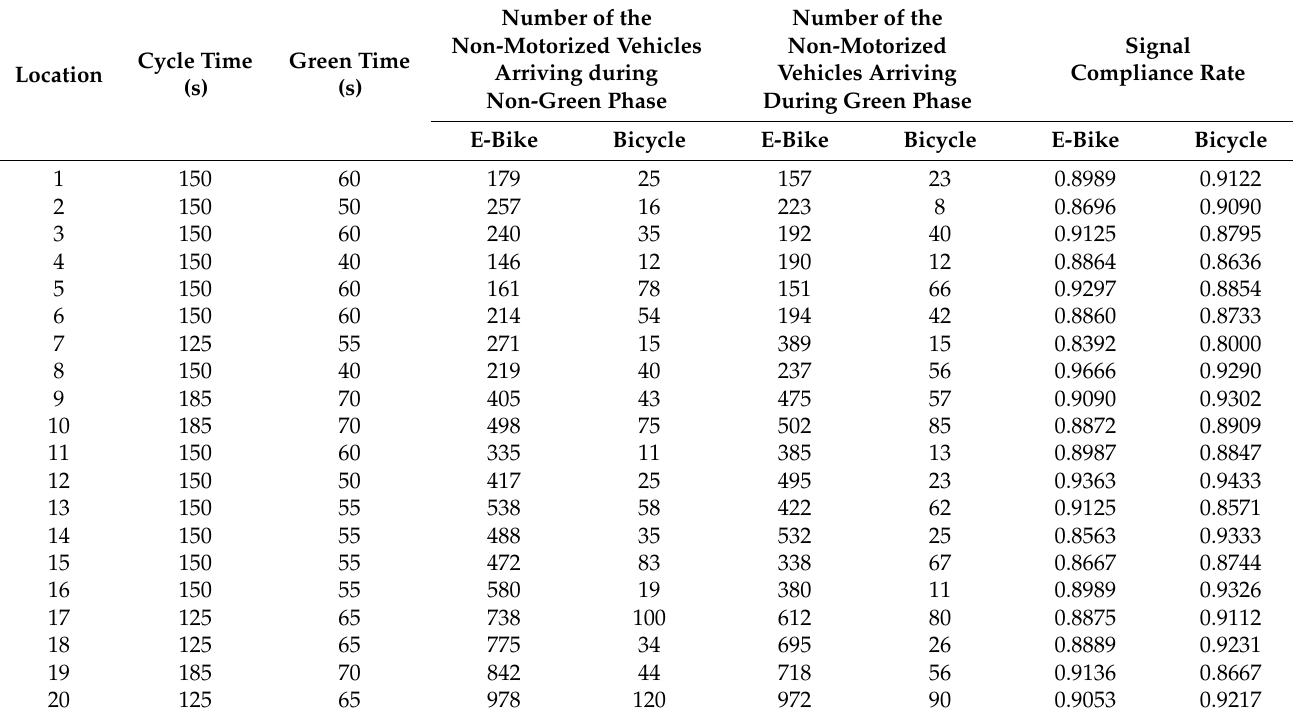
Table 1. Characteristics of Data